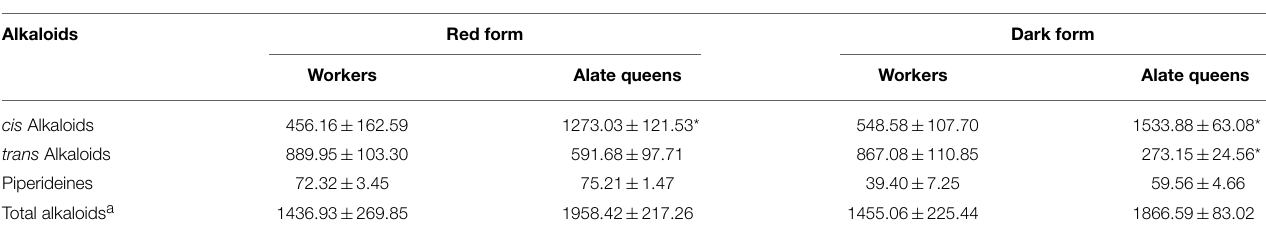
TABLE 2 | Total amounts of alkaloids ( µ g/g ±